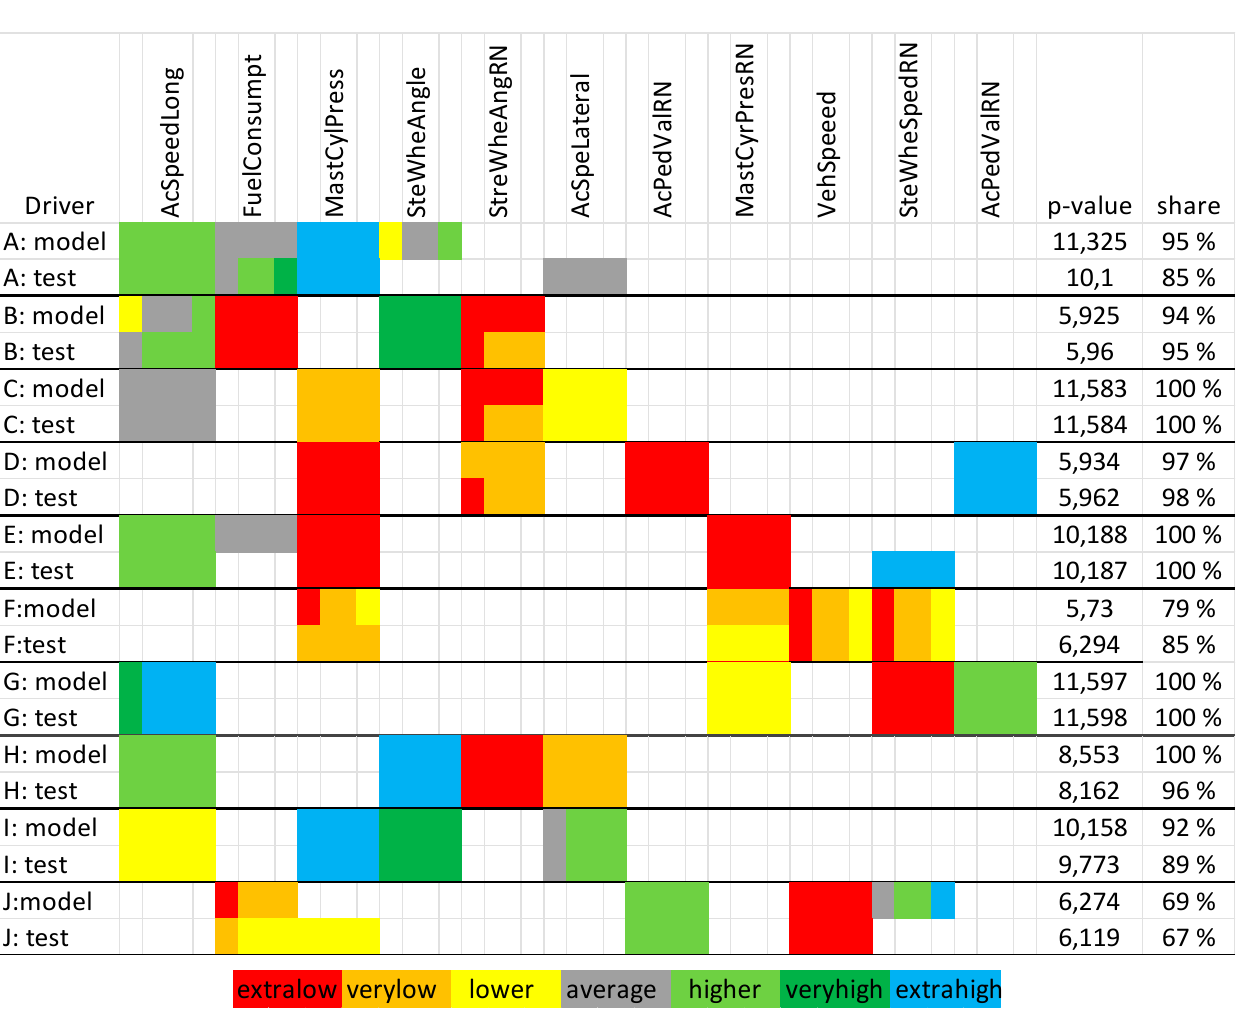
Mathematics 2021 , 9 , x FOR PEER REVIEW Figure 3. LISp-Miner answers to the analytic question ‘Which hypotheses distin- Figure 3. LISp-Miner answers to the analytic question ‘Which hypotheses distinguish each driver from all other drivers? guish each driver from all other drivers? LISp-Miner includes a Bayesian statistics-based tool to assess the reliability of results.